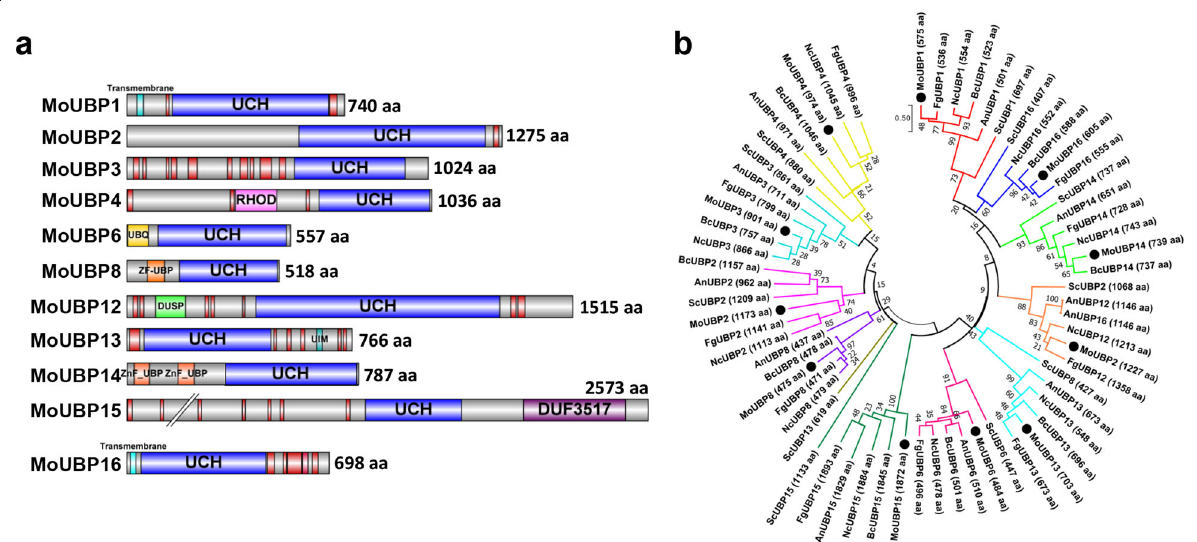
Fig. 1 The UBP family in M. oryzae . a Structures and domains of the UBP proteins in M. oryzae . UCH, ubiquitin C-terminal hydrolases; RHOD, rhodanese homology domain; UBQ, ubiquitin homologues; ZF-UBP, Zn-finger in ubiquitin-hydrolases; DUSP, domain present in ubiquitin-specific protease; UIM, ubiquitin-interacting motif; DUF, domains of unknown function; UBA, ubiquitin-associated domain. b Phylogenetic analyses of putative UBP proteins in fungi. The phylogenetic tree was constructed using MEGA7.0 by neighbour-joining method. The Bootstrap replicates were 1000. The sequences were collected from organisms as follows: Sc, Saccharomyces cerevisiae ; An, Aspergillus nidulans ; Nc, Neurospora crassa ; Mo, Magnaporthe oryzae ; Fg, Fusarium graminearum ; Bc, Botrytis cinerea . The proteins IDs of MoUBPs are shown as below: MoUBP1 (MGG_04031), MoUBP2 (MGG_00877), MoUBP3 (MGG_05996), MoUBP4 (MGG_04957), MoUBP6 (MGG_02970), MoUBP8 (MGG_03527), MoUBP12 (MGG_05666),